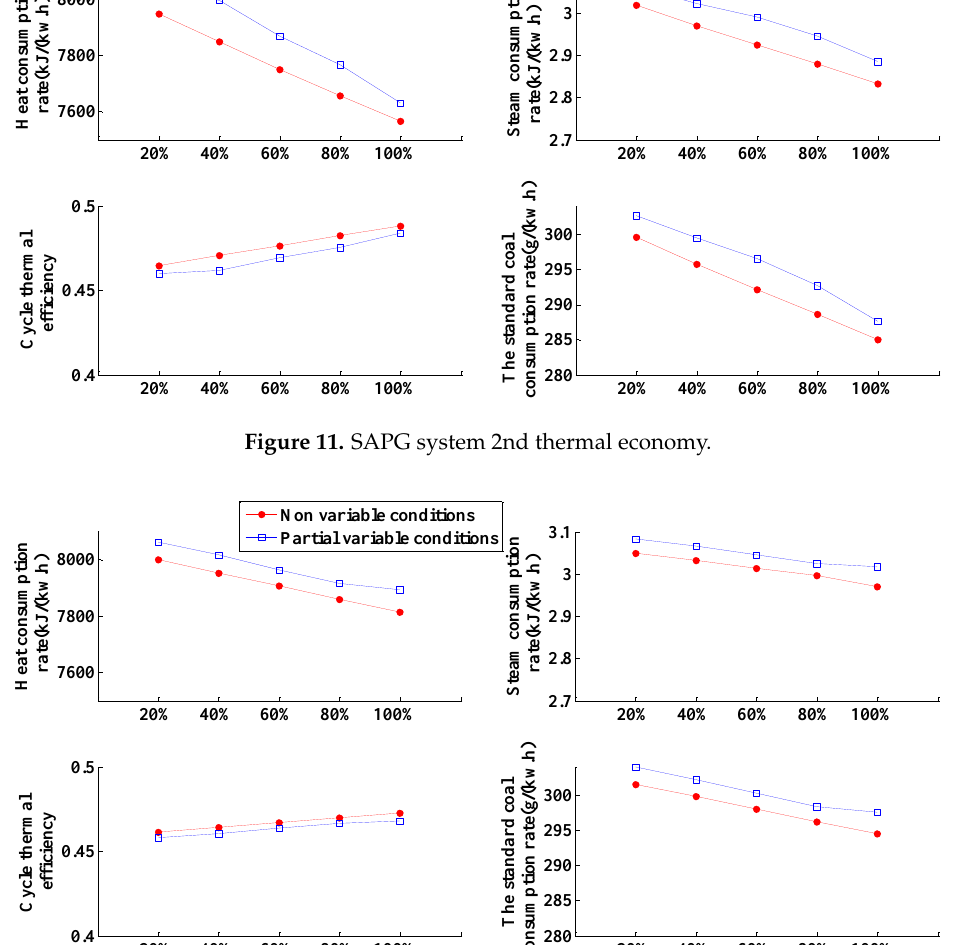
Figure 13. SAPG system 4th thermal economy.